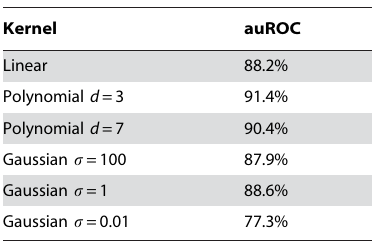
Table 1. SVM accuracy on the task of acceptor site recognition using polynomial and Gaussian kernels with different degrees d and widths s